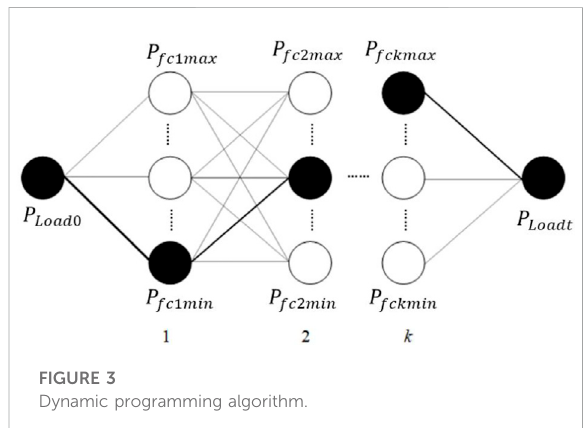
FIGURE 3 Dynamic programming algorithm.